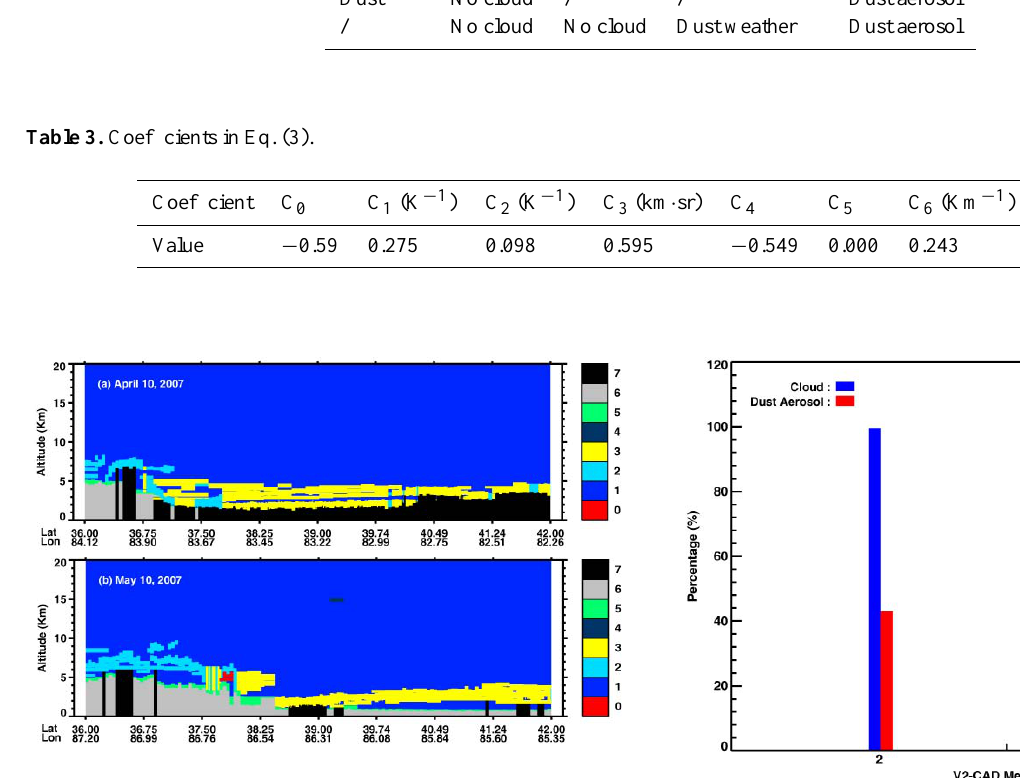
Fig. 6. CLIM method feature mask for the first case, (a) 22 April 2007, and the second case, (b) 10 May 2007, respectively.